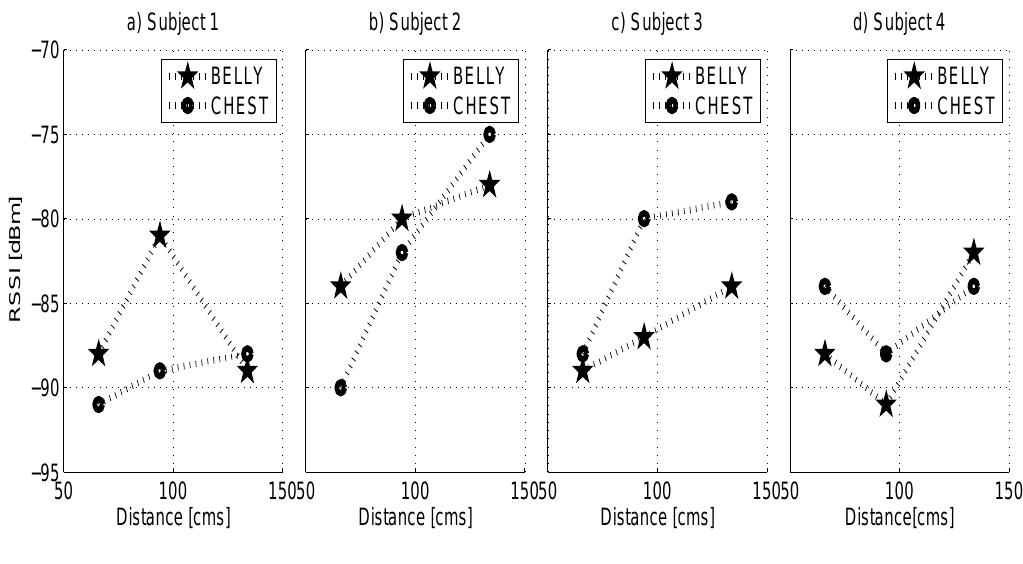
Figure 7. RSSI measures of four subjects with Shimmer node at − 10